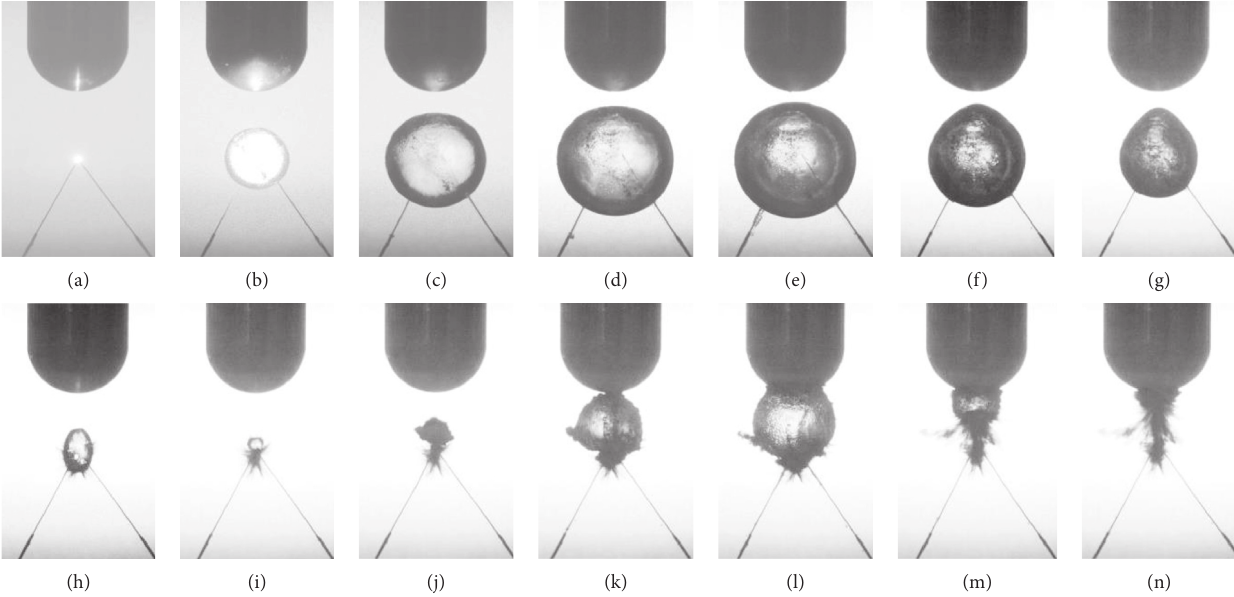
Figure 19: Diagram of bubble dynamics under the influence of hemispheric boundary for c � 1.17. (a) 0.333ms. (b) 0.875 ms. (c) 1.666ms. (d) 2.500 ms. (e) 3.583ms. (f) 5.041 ms. (g) 5.499ms. (h) 6.041 ms. (i) 6.124ms. (j) 6.208ms. (k) 6.791 ms. (l) 8.124ms. (m) 9.749ms. (n)